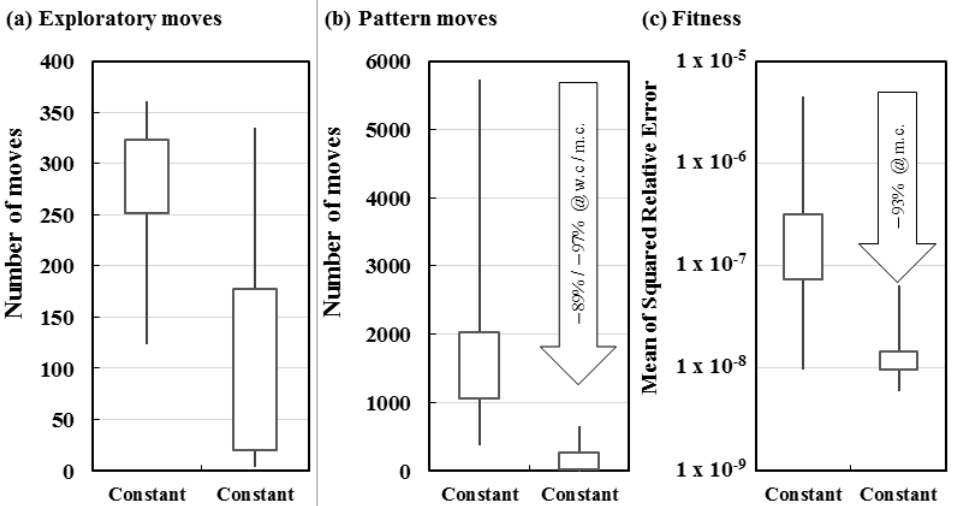
Figure 6. The benchmark results of sequential exploration and parallel exploration. To be fair in comparison, 10 samples of the target curves are randomly chosen and used on both implementations. The scale factor = 0.1 is configured in this benchmark. ( a ) The number of moves in exploratory move; ( b ) the number of moves in pattern move; ( c ) fitness distribution of the calibrated parameters; w.c. refers to worst case and m.c. refers to median case. A top/bottom edge of the whisker in the plot represents the maximum/minimum datum, respectively.